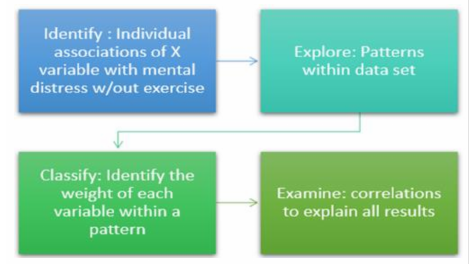
Figure 1. Study design rationale.